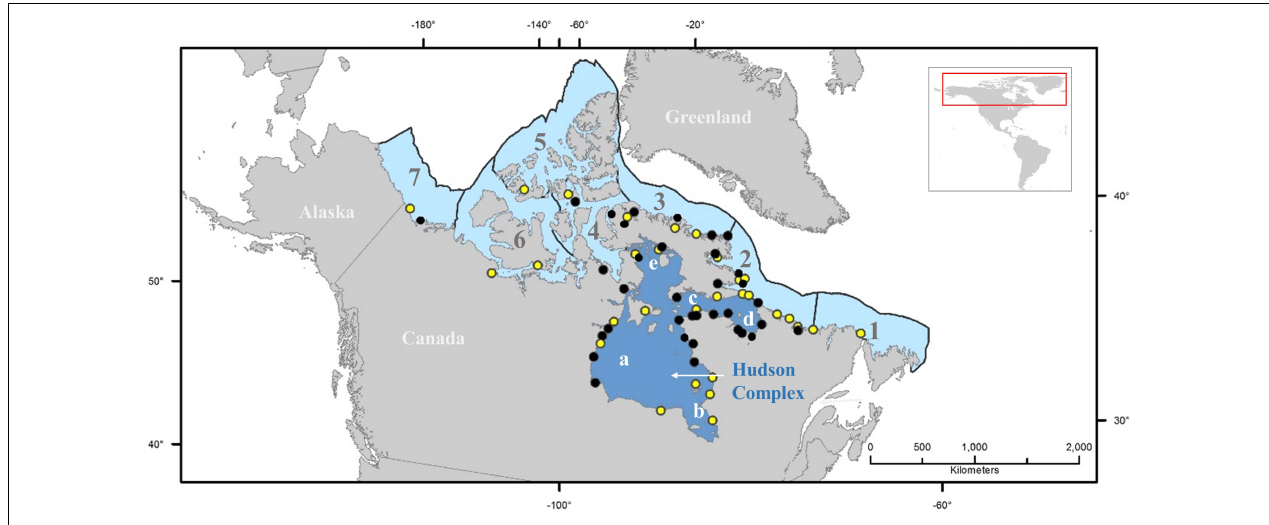
FIGURE 1 | Map showing the location of the risk assessment area (Hudson Bay Complex, composed of (a) Hudson Bay; (b) James Bay; (c) Hudson Strait; (d) Ungava Bay; and (e) Foxe Basin). Numbers shown represent the other Canadian Arctic ecoregions as delineated by Spalding et al. (2007): (1) Northern Grand Banks-Southern Labrador; (2) Northern Labrador; (3) Baffin Bay-Davis Strait; (4) Lancaster Sound; (5) High Arctic Archipelago; (6) Beaufort-Amundsen-Viscount Melville-Queen Maud; and (7) Beaufort Sea-continental coast and shelf. Dots represent Canadian Arctic ports known to receive ballast water discharges (black), and ports without registered discharges of ballast water but that could be affected by biofouling (yellow) (Chan et al., 2012; Goldsmit et al., 2019; DFO (Department of Fisheries and Oceans), 2020).